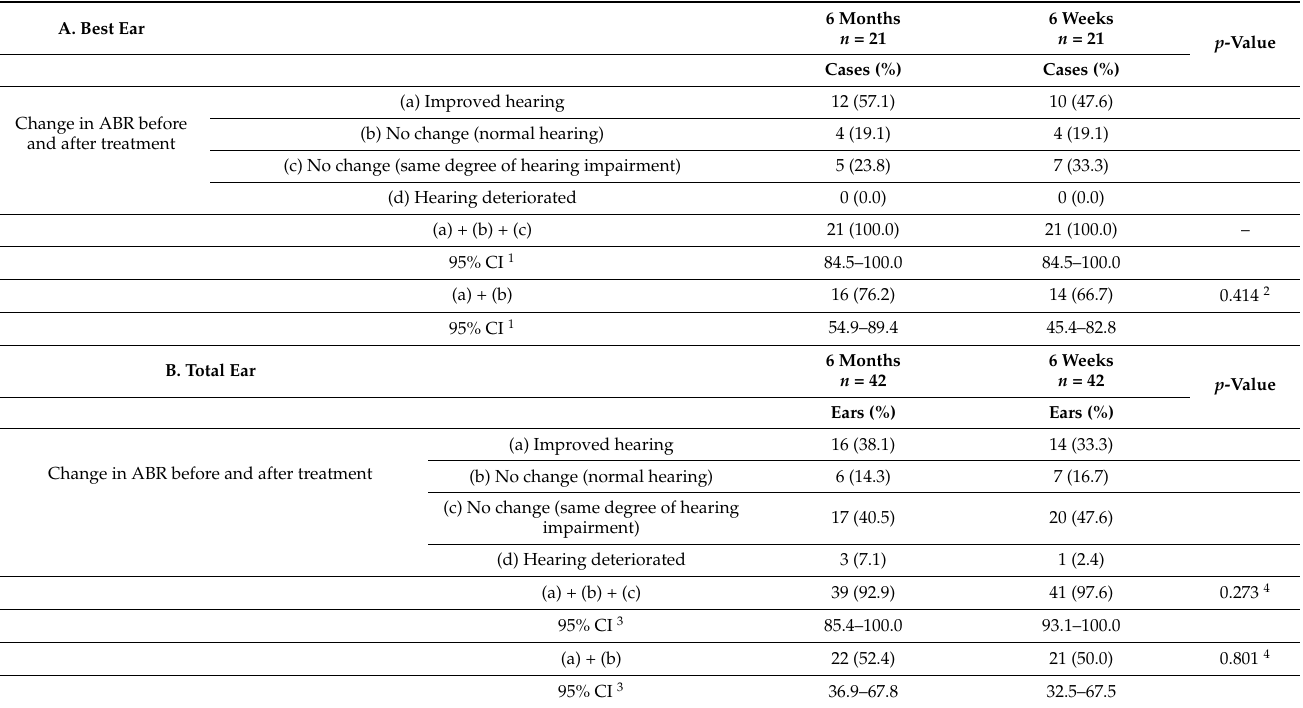
Table 4. Comparisons of best ear and total ear hearing using auditory brainstem responses before and after 6 months and 6 weeks of